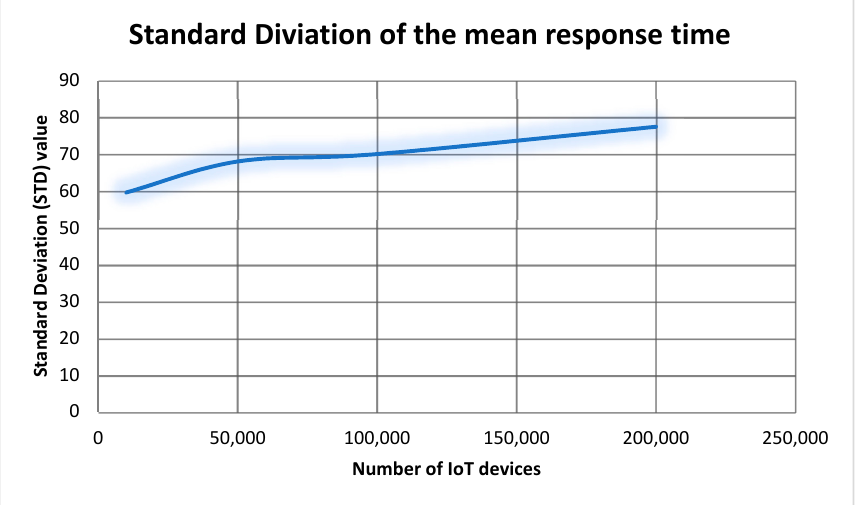
Figure 13. The relationship between the number of integrated IoT devices and the standard devia- tion.